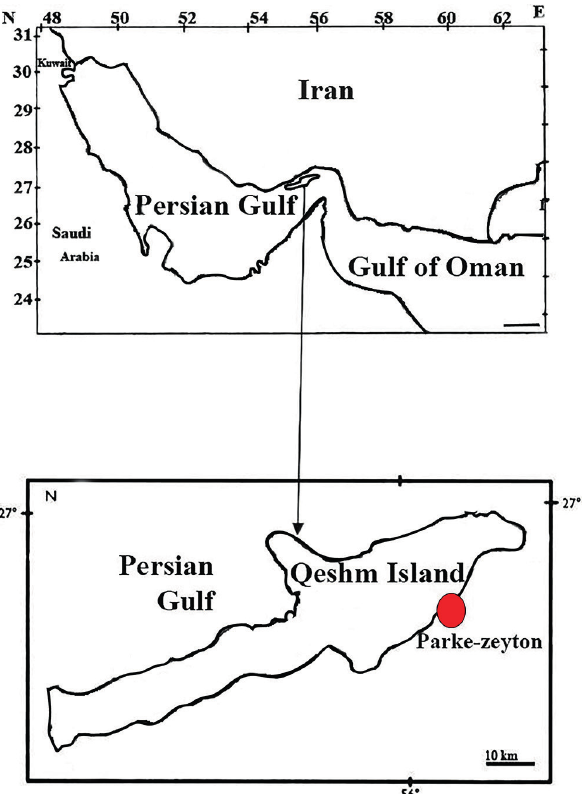
Figure 1. The type locality of Clausidium persiaensis sp. nov. (Red